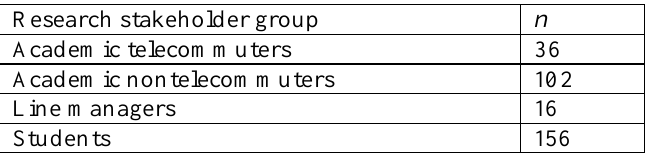
Research Stakeholder Sample Size